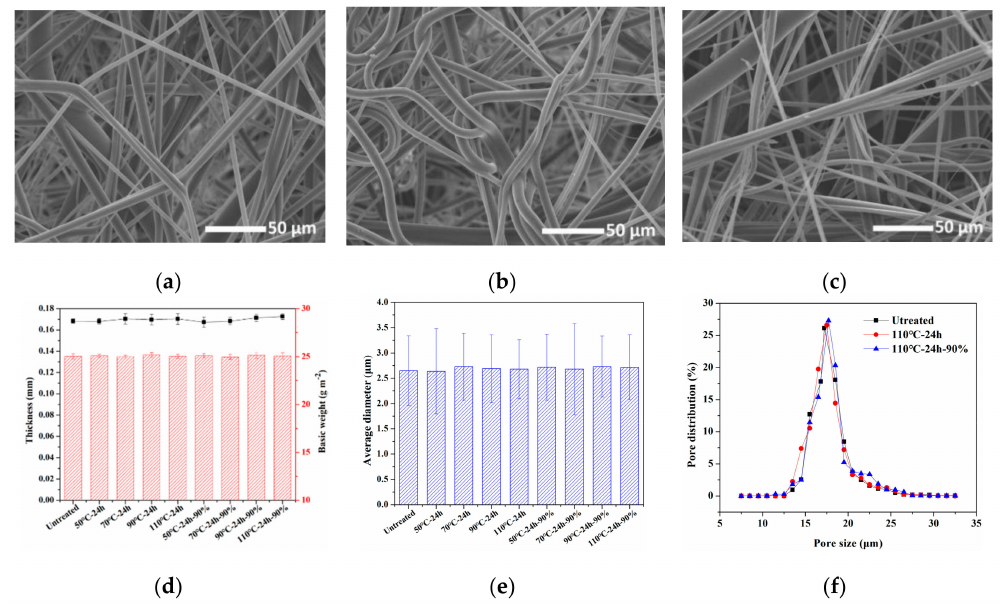
Figure 5. Morphology, structure, fiber diameter, and pore size of melt-blown nonwovens. SEM images of melt-blown nonwovens after various heat treatment conditions: ( a ) untreated sample, ( b ) 110 ◦ C-24 h, and ( c ) 110 ◦ C-24 h-90%. ( d ) Thickness and basic weight, ( e ) fiber average diameter, and ( f ) pore size distribution